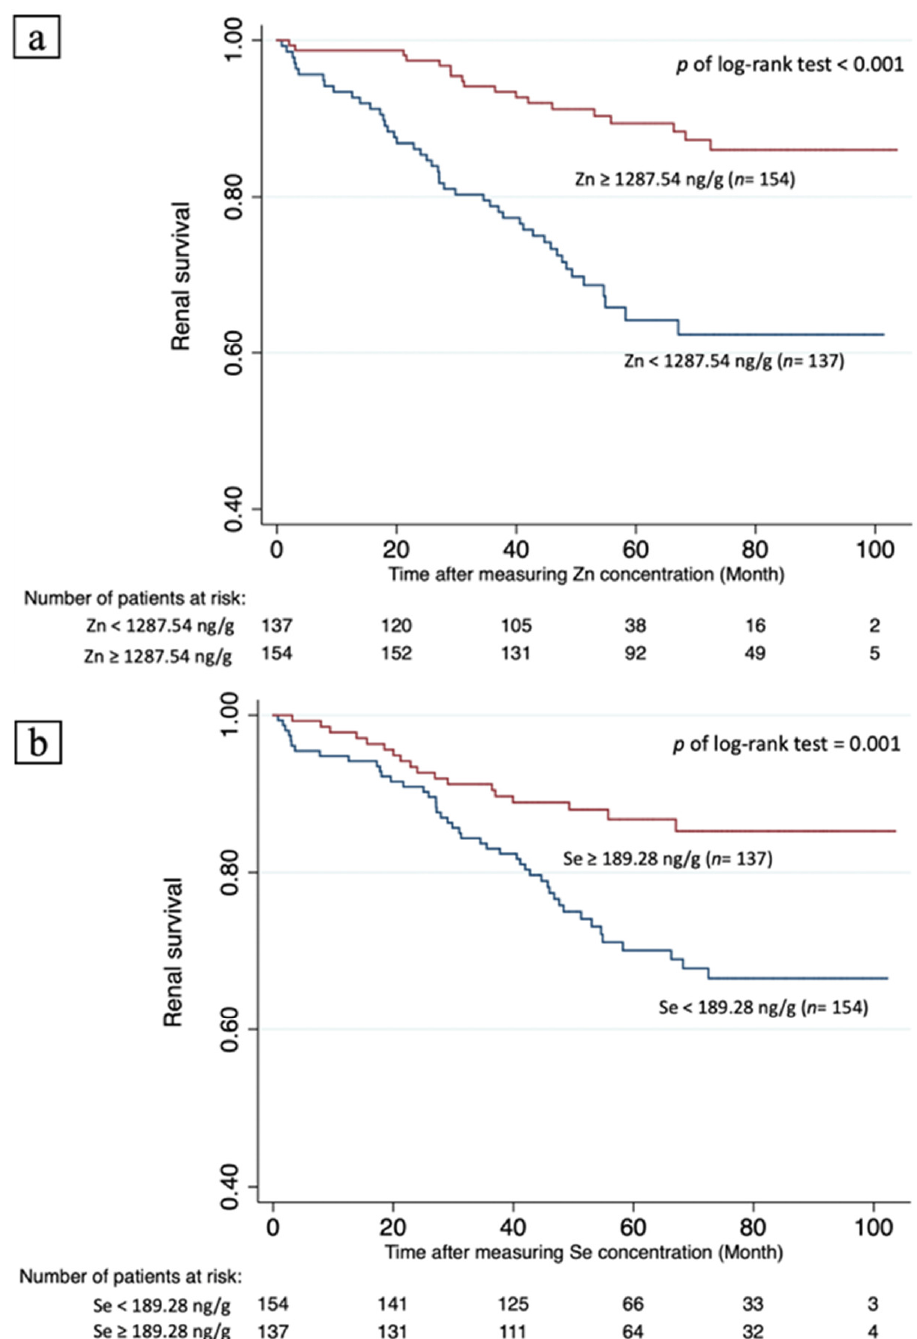
Figure 3. Kaplan–Meier survival curves in all participants according to serum zinc and selenium concentration. Renal survival was significantly better for individuals with Zn levels ≥ 1287.24 ng/g (n = 137) than for those with Zn levels <1287.24 ng/g (n = 154) (Cox–Mantel log rank test, p < 0.001) (Panel ( a )). Individuals with Se levels ≥ 189.28 ng/g (n = 154) had significantly better renal survival than those with Se levels <189.28 ng/g (n = 137) (Cox–Mantel log rank test, p = 0.001) (Panel ( b )).